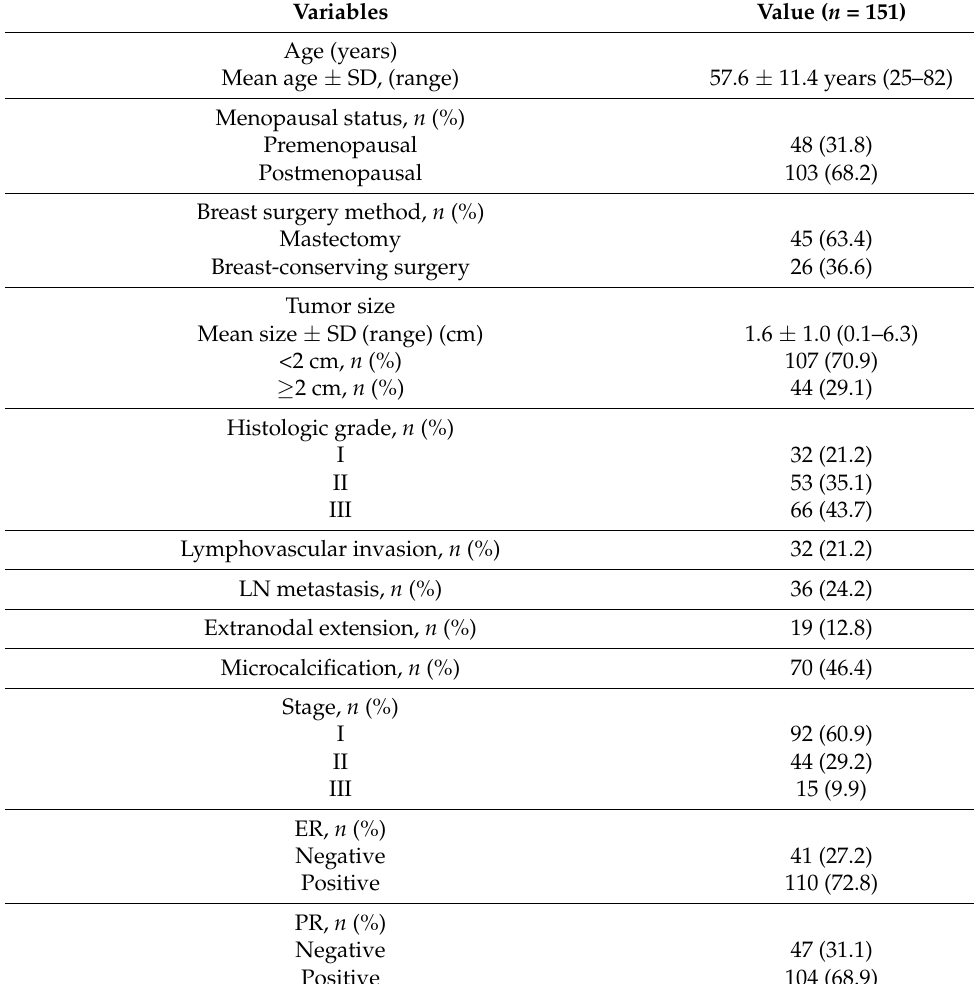
Table 1. The clinicopathological characteristics of